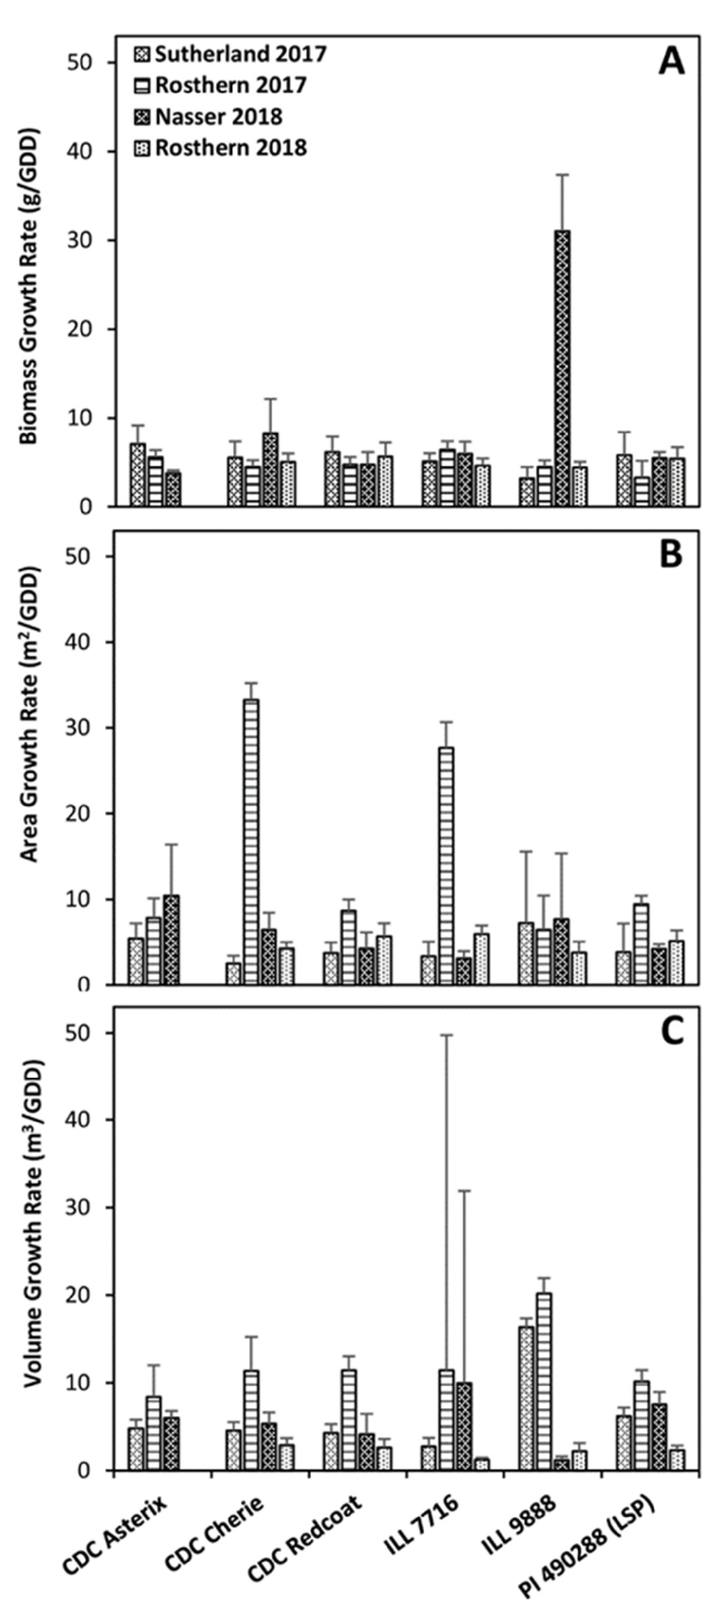
Figure 2. Estimated growth rate parameters: for dry weight biomass ( A ), vegetation area ( B ), and plot volume ( C ) are displayed for each genotype at each site-year. Error bars show standard error.